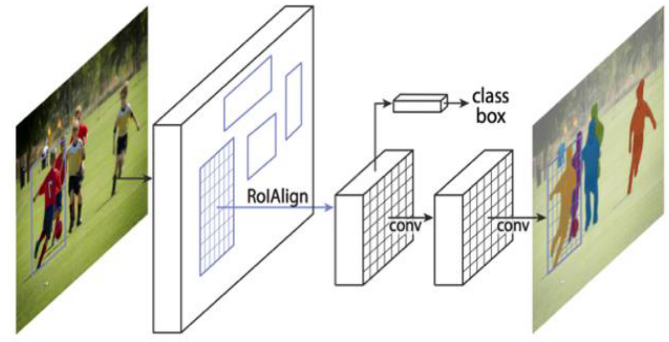
Figure 2. The Mask R-CNN architecture